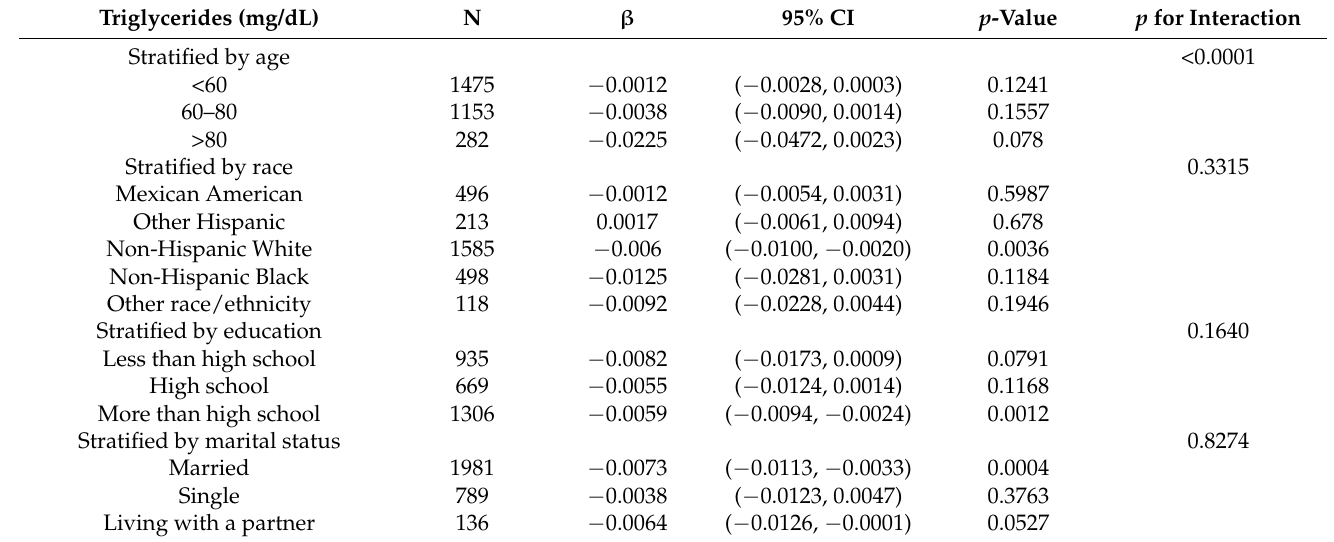
Table 3. Effect size of triglycerides on PSA in the prespecified and exploratory